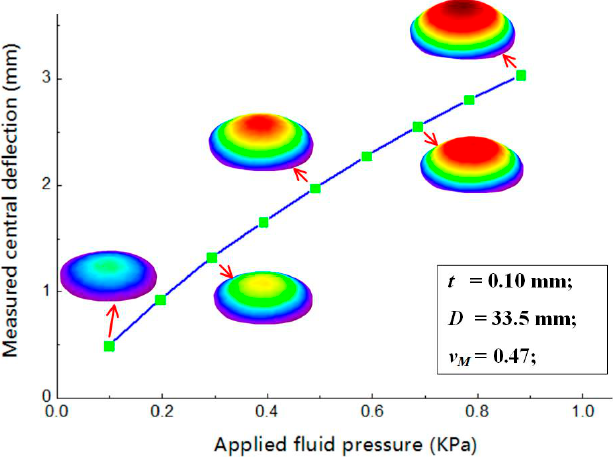
Figure 10. The relation between the measured central deflection w 0 and applied fluid pressure P.